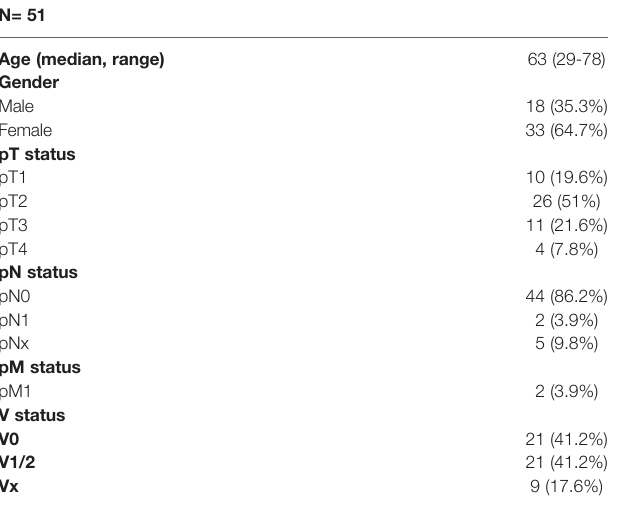
TABLE 1 | Demographic and tumor characteristics of HCC patients included in the present study. N= 51 Age (median, range) 63 (29-78)